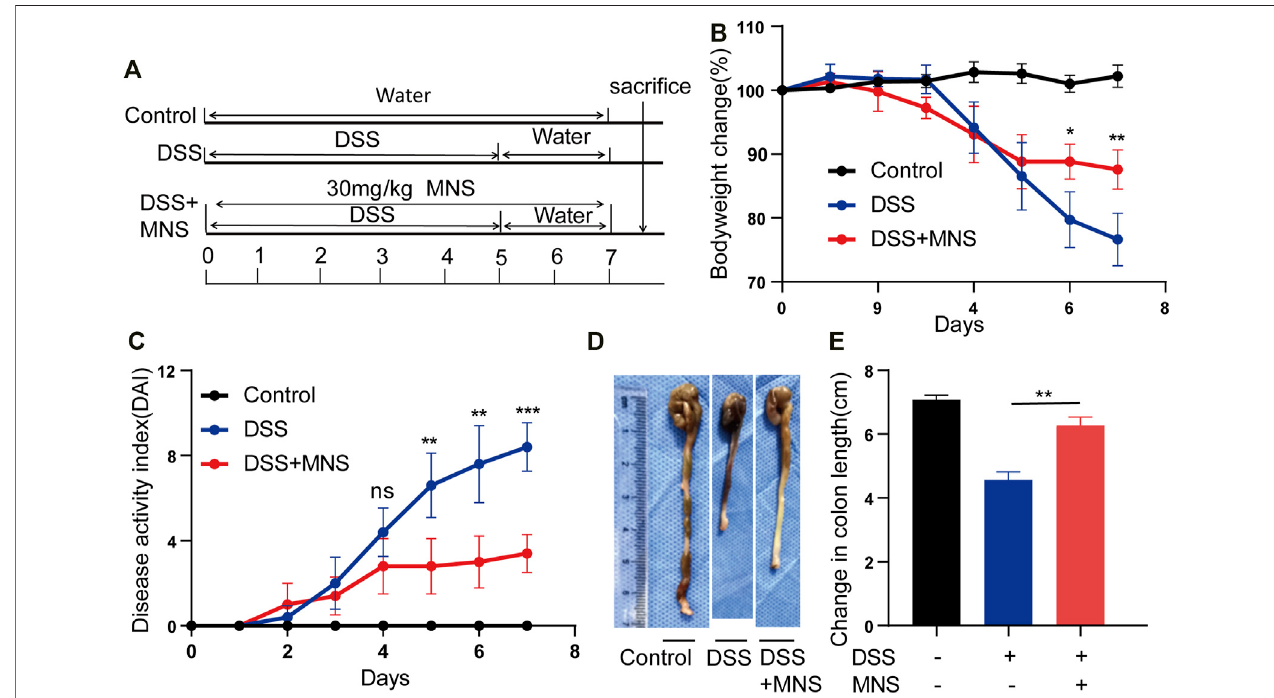
FIGURE 3 | MNS relieved DSS-induced colitis symptoms. (A) Experimental DSS-induced colitis protocol. (B) Percentage of body weight loss in mice treated with DSS alone (blueline), DSS+MNS(red line),and Controlmice (black line). (C) Diseaseactivity index (DAI)in micetreatedwithDSSalone(blueline),DSS +MNS(redline), and Control mice (black line) over 7 days. (D) Gross colonic anatomy showing the shortening effects of MNS on DSS-induced colon. (E) Colon length was measured at autopsy. N = 3 mice/group. Data were presented as the mean ± standard error of the mean (SEM). In (B,C,E) * p < 0.05, ** p < 0.01, and *** p < 0.001 vs. the DSS